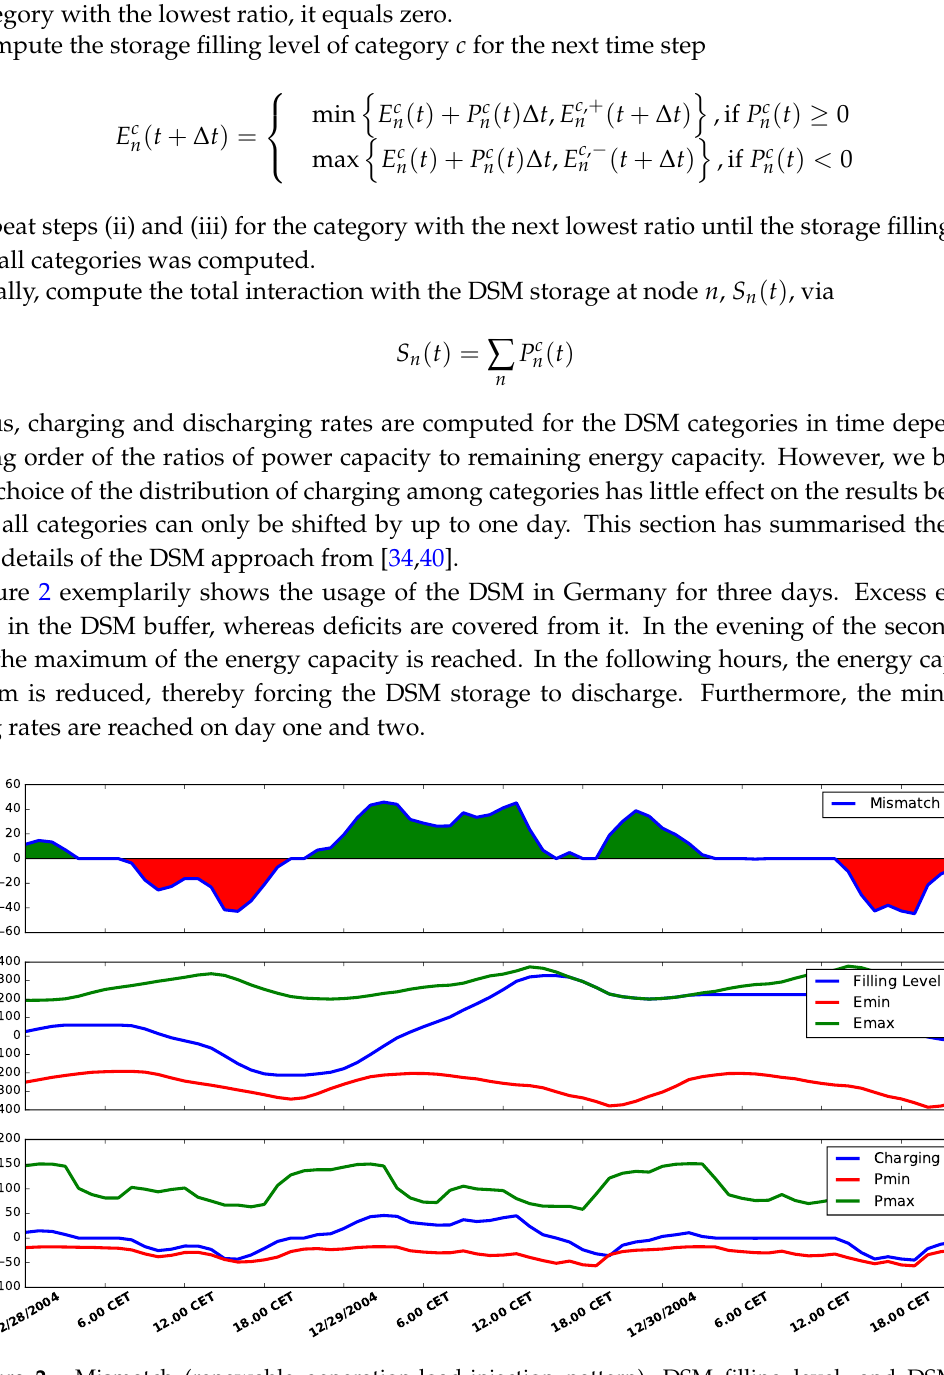
Figure 2. Mismatch (renewable generation-load-injection pattern), DSM filling level, and DSM charging rates for three exemplary days in